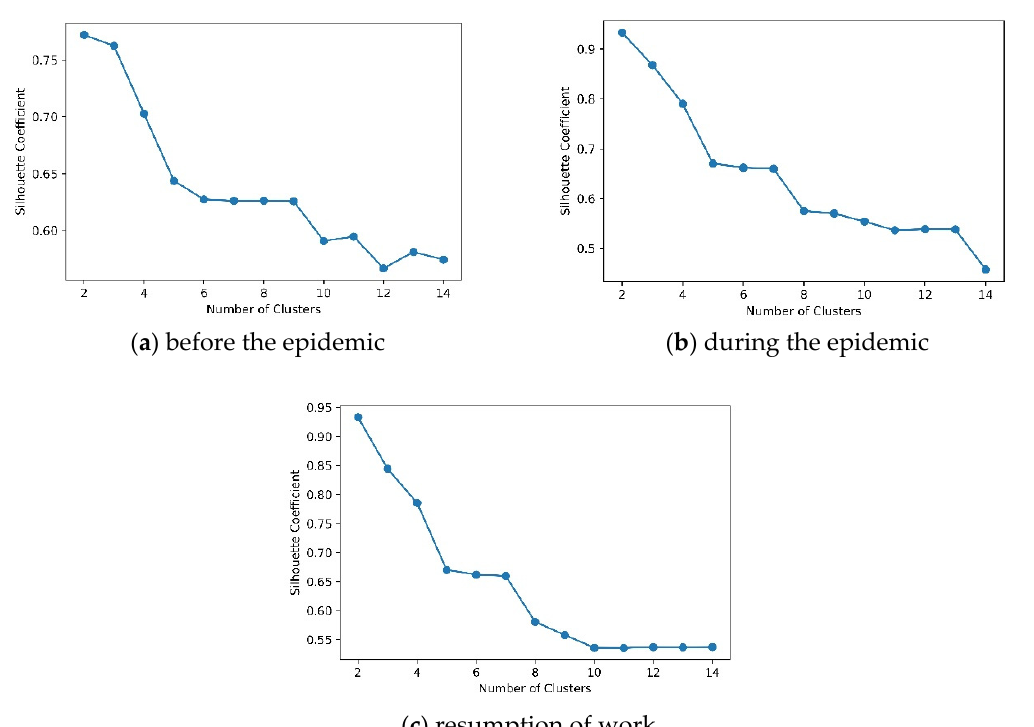
Figure 4. Relationship between the Silhouette coefficient and K values at different stages of the epidemic.